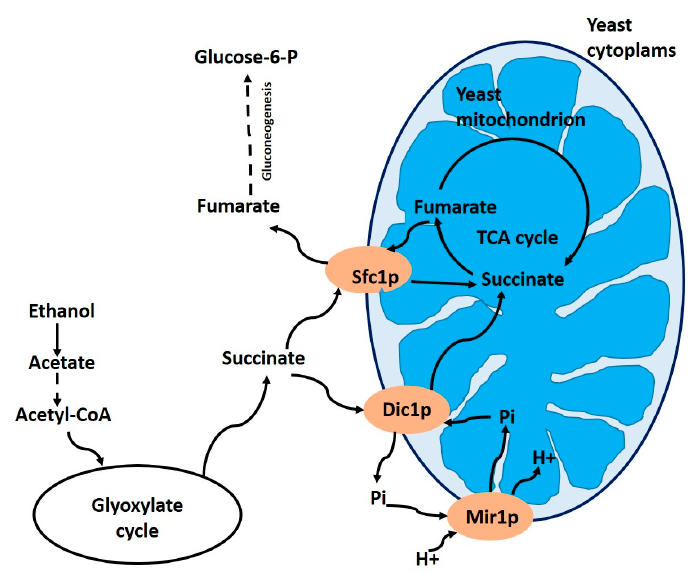
Figure 3. Schematic representation of the actions of the mitochondrial Dic1p carrier and the Sfc1p mitochondrial succinate/fumarate carrier, when yeast cells are grown on acetate or ethanol as the sole carbon source. Abbreviations: TCA cycle, tricarboxylic acid cycle; Mir1p, mitochondrial phosphate carrier; Pi, phosphate. Adapted from Palmieri et al. [51].